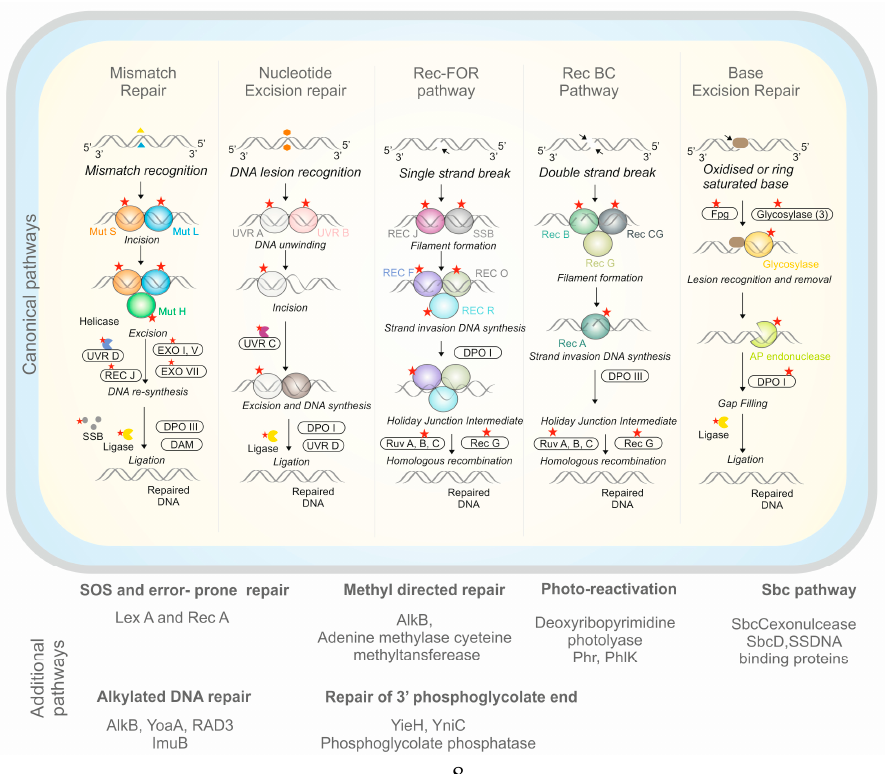
Figure 5. DNA repair genes and pathways putatively responsible for UV tolerance in Salinivibrio sp. HTSP based on genome analysis. The red star indicates the presence of gene in each pathway stands for the possible mechanism of DNA